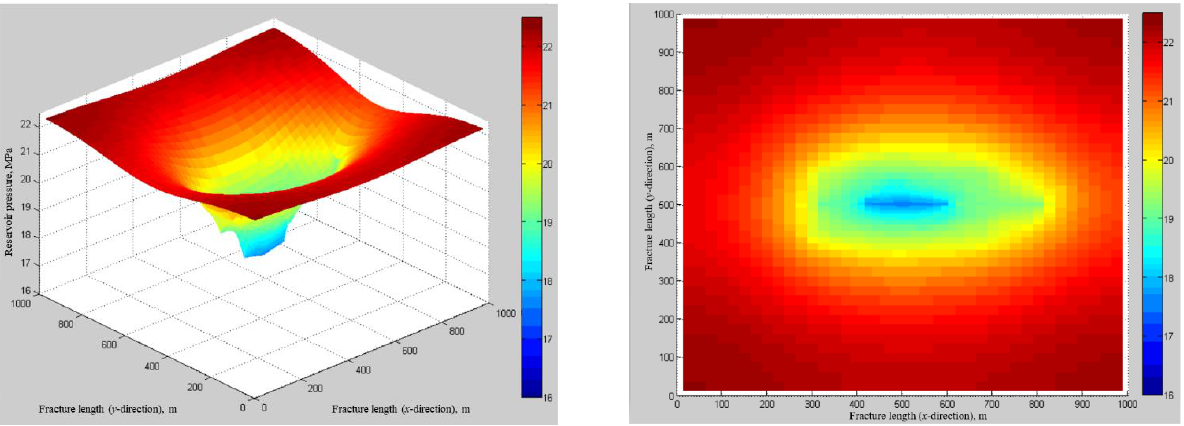
Figure 14. Reservoir pressure distribution at the time of two years.